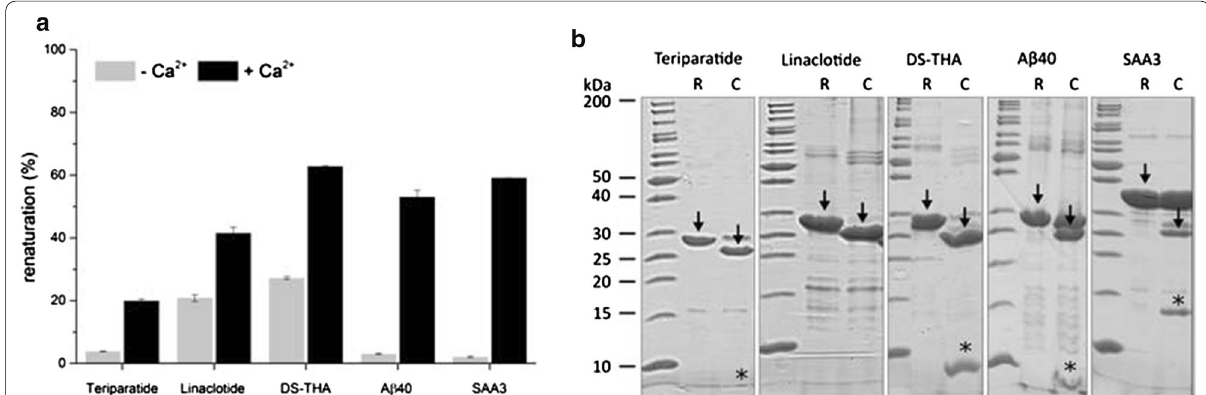
Fig. 3 Renaturation efficiencies and TEV protease cleavage of HlyA1 fusions. a Renaturation efficiencies (%) of HlyA1 fusions in the presence or absence of 10 mM Ca 2 + ions. 100% renaturation efficiency corresponds to the adjusted protein concentration for the renaturation reaction. Error bars indicate the SD (n 3). b SDS‑PAGE analysis (Coomassie‑stained) of renatured HlyA1 fusions prior to and after TEV protease cleavage. Arrows = indicate the HlyA1 fusions after renaturation (R) and HlyA1 after TEV protease cleavage (C). Signals were found for each target but Linaclotide. Due to visualization limits of Coomassie staining, the location is highlighted (*). Release of targets was further assessed by RP‑HPLC analysis (Additional file 1: Fig. S3)